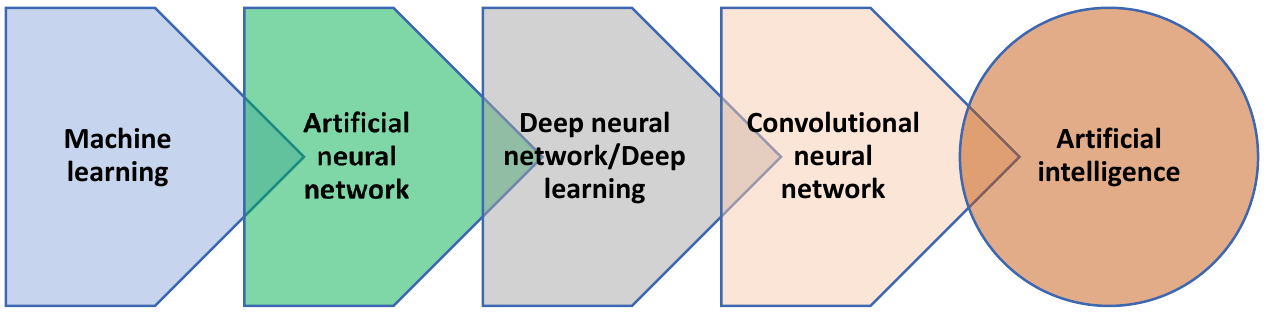
Figure 3. Progressive increase in the levels of complexity from machine learning to CNN in AI pro- grams.